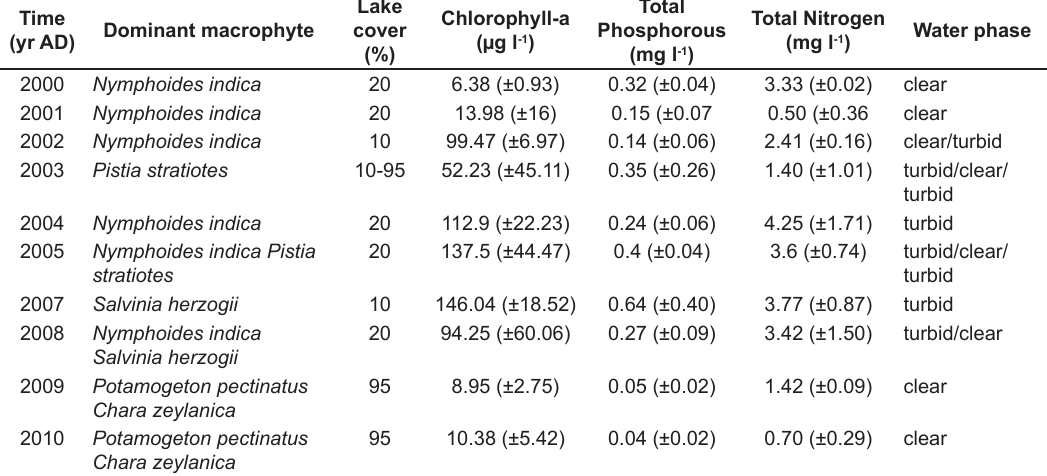
Table 1. Inter-annual changes in limnological conditions of Lake Biguás. Modified from Silva et al. (2015). Nymphoides indica is currently renamed Nymphoides humboldtiana , and Potamogeton pectinatus is currently renamed Stuckenia pectinata